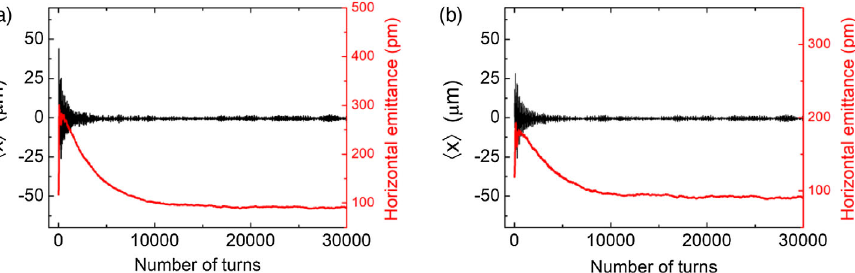
FIG. 11. Centroid oscillation (black line) and emittance growth (red line) along turn by turn for the cases of rf error with 0.2° phase deviation and 0.1% voltage error (a) and rf error with − 0 . 2 ° phase deviation and − 0 . 1 % voltage error (b). The emittance blowup is temporary and damps down in 10 000 turns (19.33 ms